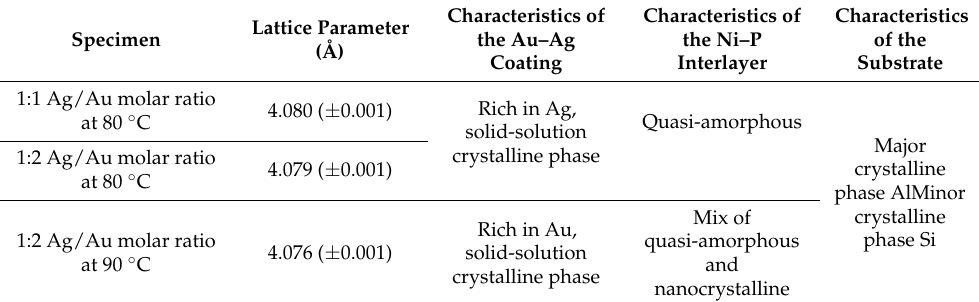
Table 6. Phase identification and electrum lattice parameter for the Au-Ag coated specimens.